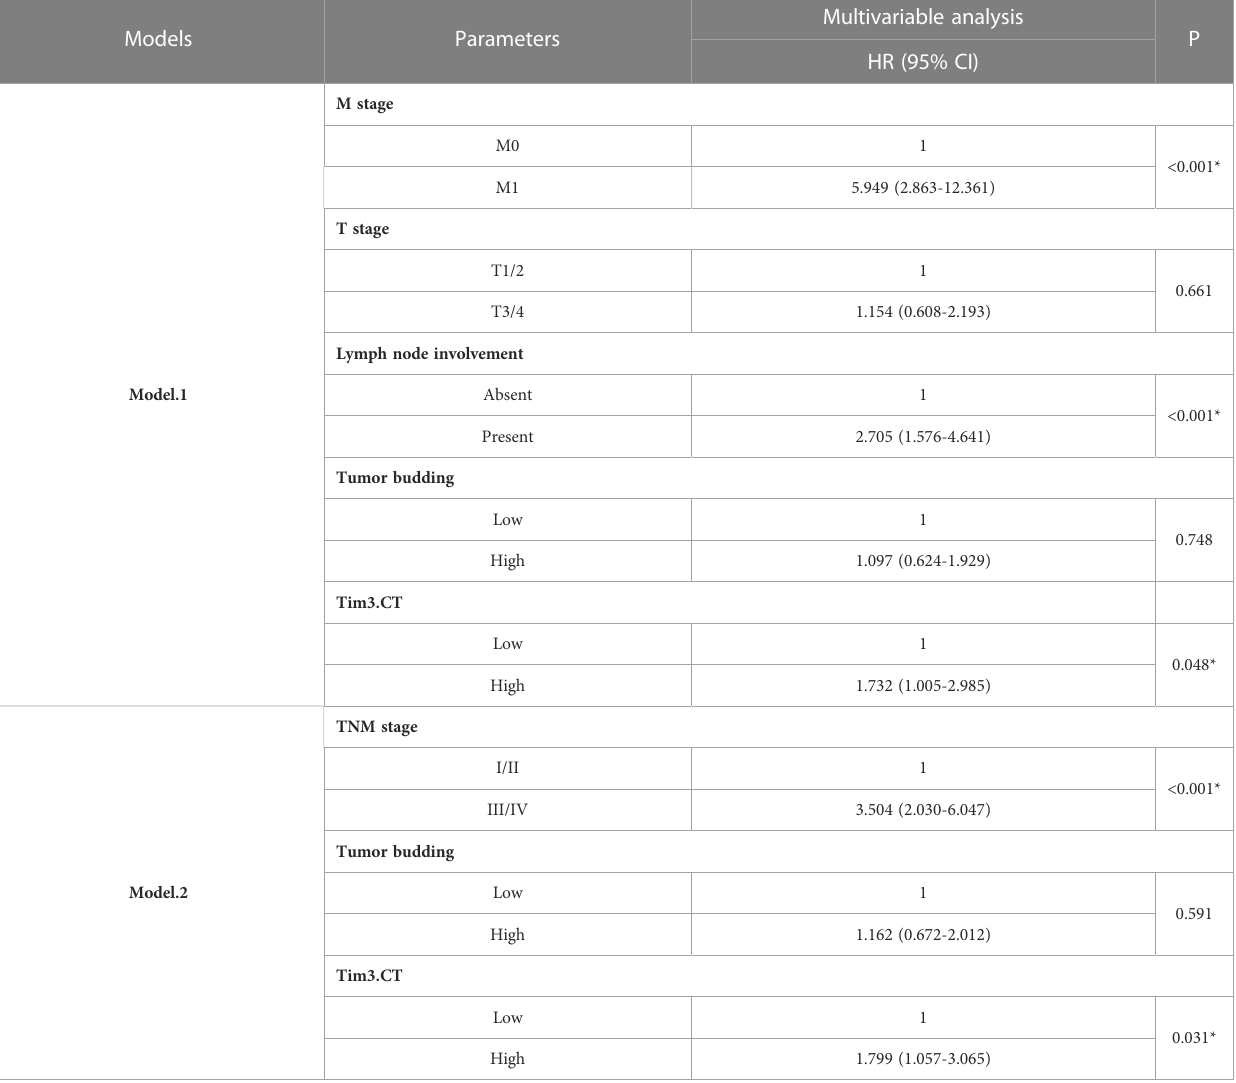
(HR= 0.343, 95% CI= 0.138-0.852, P= 0.021). In addition, high Tim3 expression in CT was signi fi cantly associated with poor OS in patients with high CD8 expression in this region (HR= 3.032, 95% CI= 1.338-6.869, P= 0.008) (detailed in Table 8).